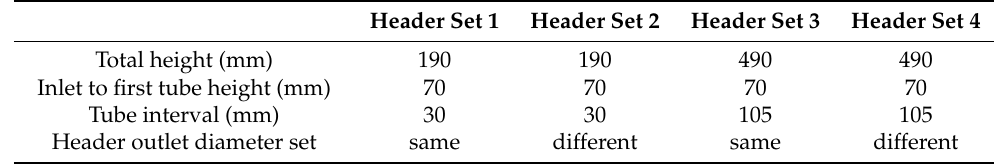
Table 2. Details of the four header sets.